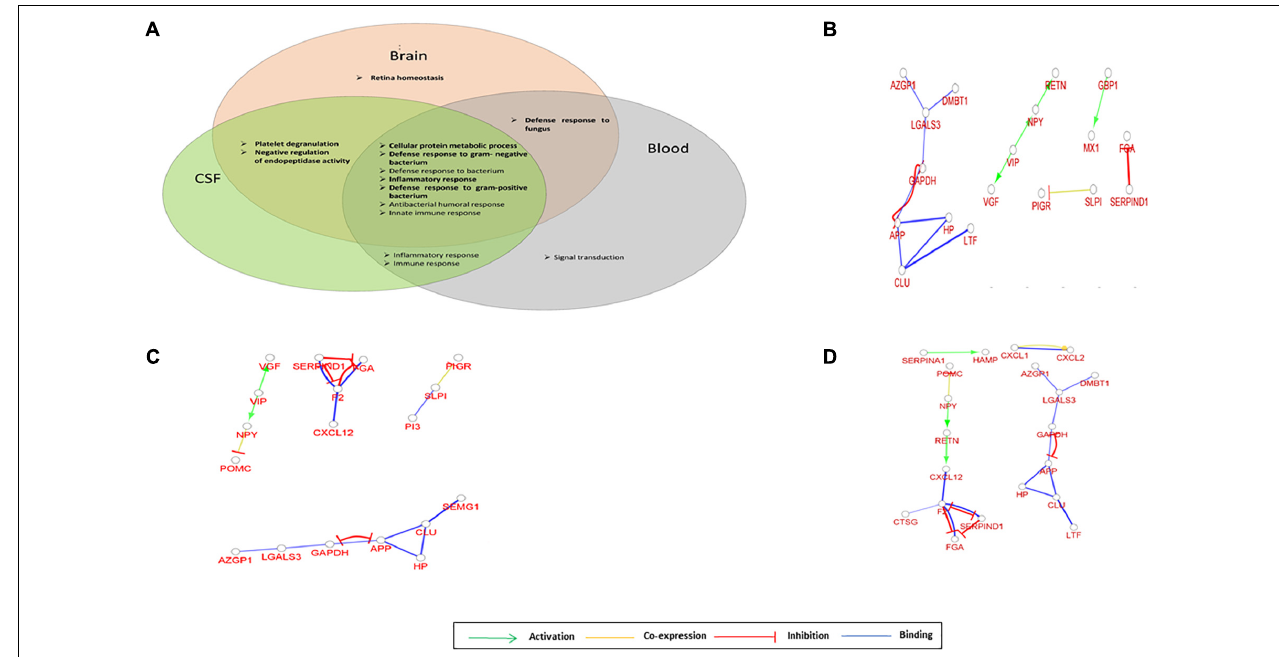
FIGURE 2 | Network of AMPs characteristic for brain, cerebrospinal fluid (CSF) and blood. (A) Venn diagram of the top 10 enriched GO terms for AMPs identified in the brain, CSF, or blood. (B) Gene interaction network characteristic for AMPs identified in brain. (C) Gene interaction network characteristic for AMPs identified in CSF. (D) Gene interaction network characteristic for AMPs identified in blood. The circles represent a gene/protein and the lines indicate interactions. The lines with arrow represent activation, blocking lines represent inhibition, simple lines represent protein–protein interaction. Line color indicates the type of interaction: green color refers to activation, red color to inhibition, blue color to binding, whereas yellow color shows co-expression. On all panels the proteins are labeled with their gene